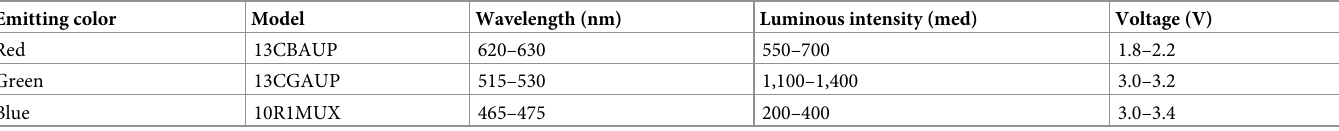
Table 2. Properties of LEDs used in this